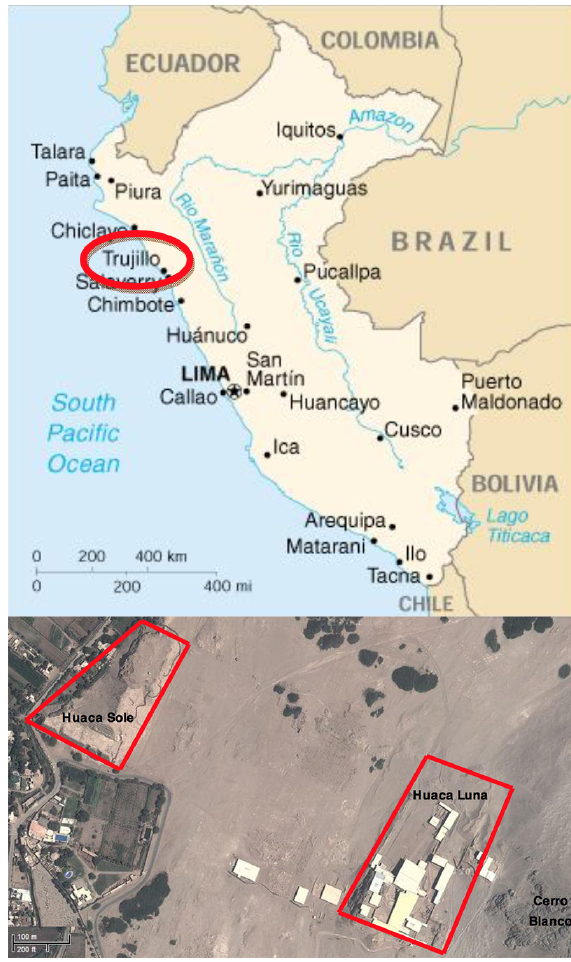
Figure 1. Geographical location of the site. Top image represents the territorial framework, the bottom image represents the orto- photo with the two main Huacas in the